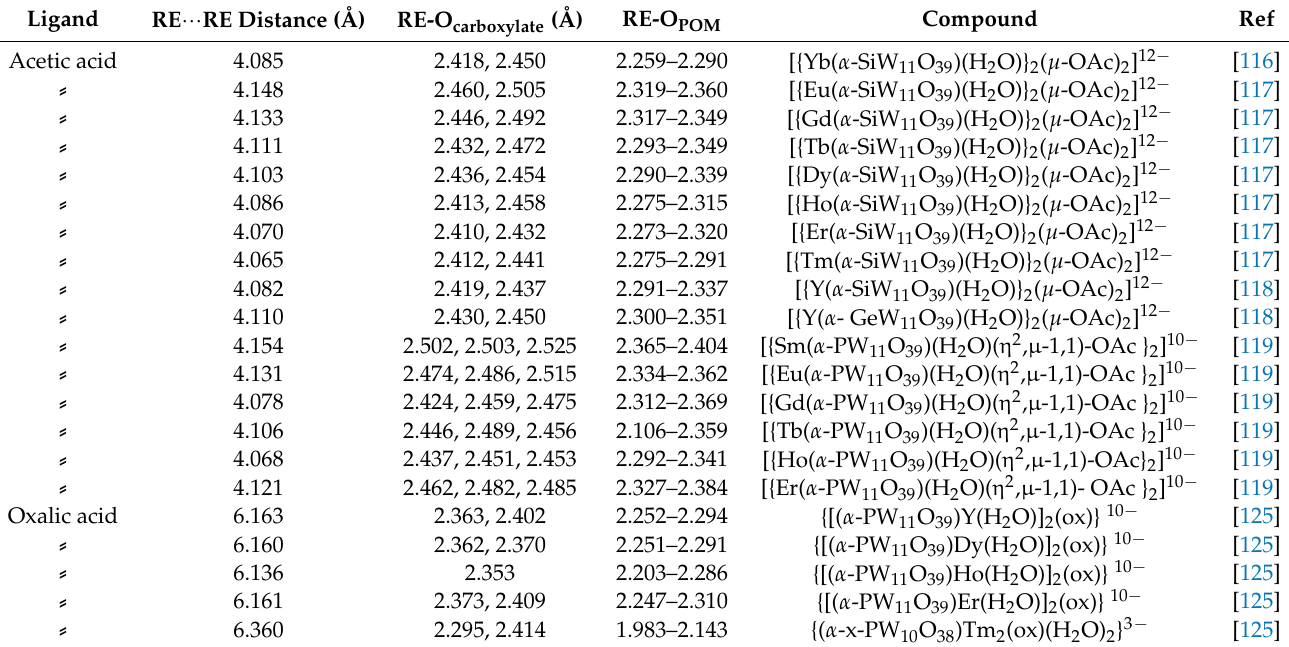
Table 2. List of bridging ligands and their characterization in the dimeric inorganic–organic hybrids based on RESPs. Ligand